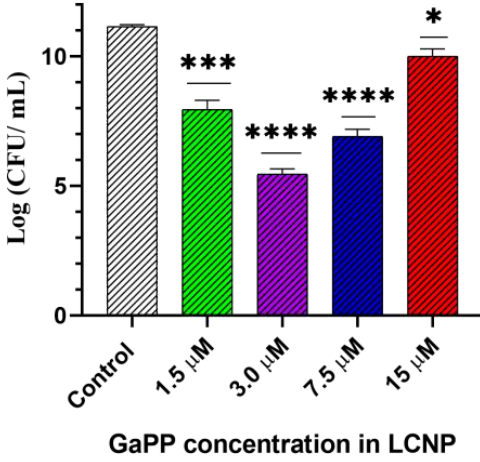
Figure 11. Viability of P. aeruginosa biofilm following treatment with different concentrations of GaPP-LCNP, light dose 34.2 J/cm 2 , compared to saline control in the dark. Data presented as mean ± SD, n = 3. Significant reduction was calculated using one-way ANOVA test followed by Dunnett’s multiple comparison test. * p = 0.026, *** p = 0.0002, **** p < 0.0001.